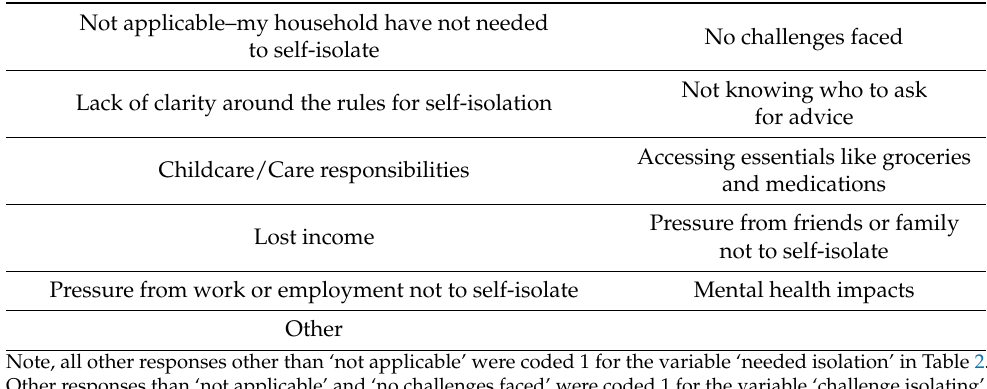
Table A2. What challenges have you faced in completing self-isolation for the Coronavirus (COVID-19)? (please tick all that apply).